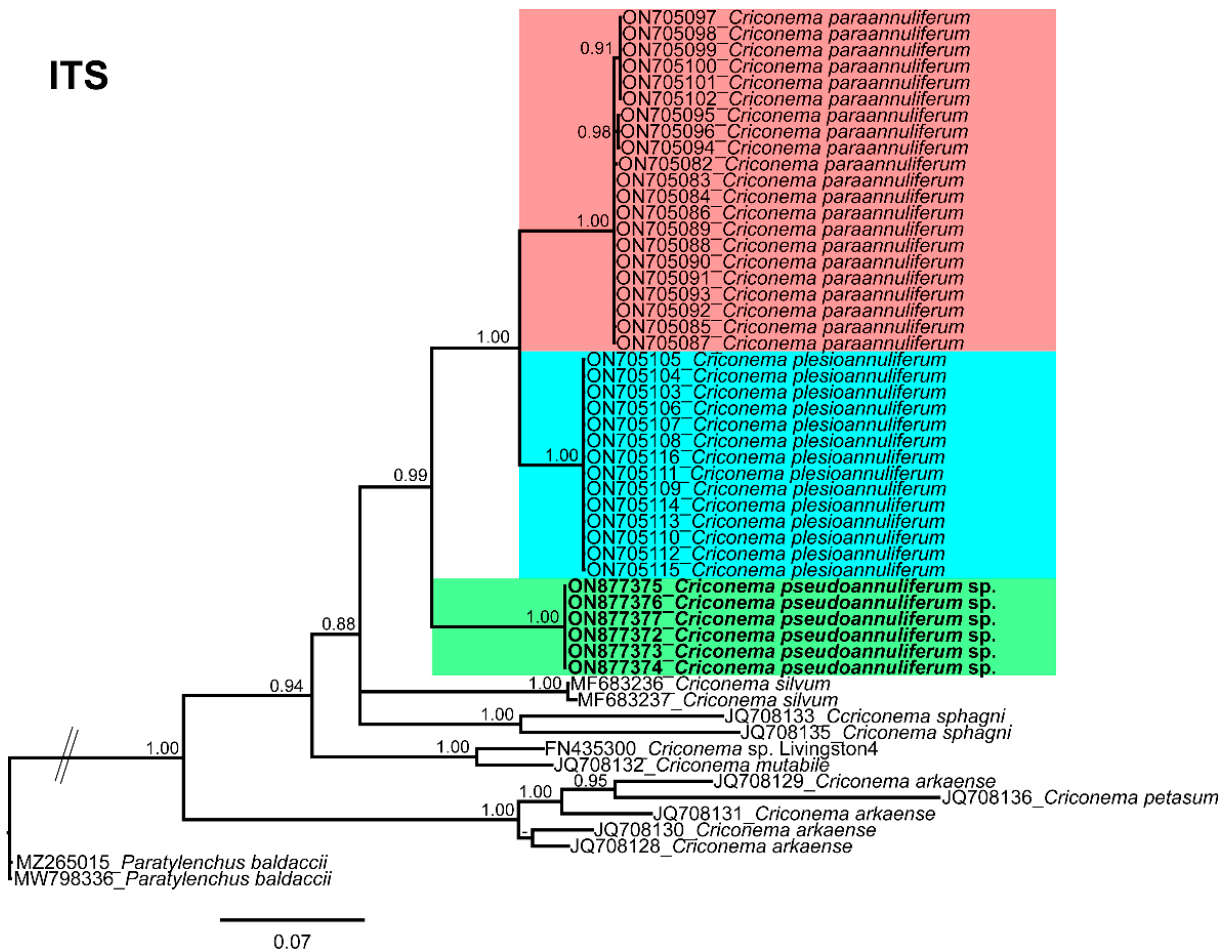
Figure 8. Phylogenetic relationships within the genus Criconema . Bayesian 50% majority rule consensus tree as inferred from ITS rRNA sequence alignment under the transversion model with invariable sites and a gamma-shaped distribution (TVM + I + G). Posterior probabilities of more than 0.70 are given for appropriate clades. Newly obtained sequences in this study are shown in bold. The scale bar indicates expected changes per site, and the coloured boxes indicate the clade association of Criconema annuliferum complex.